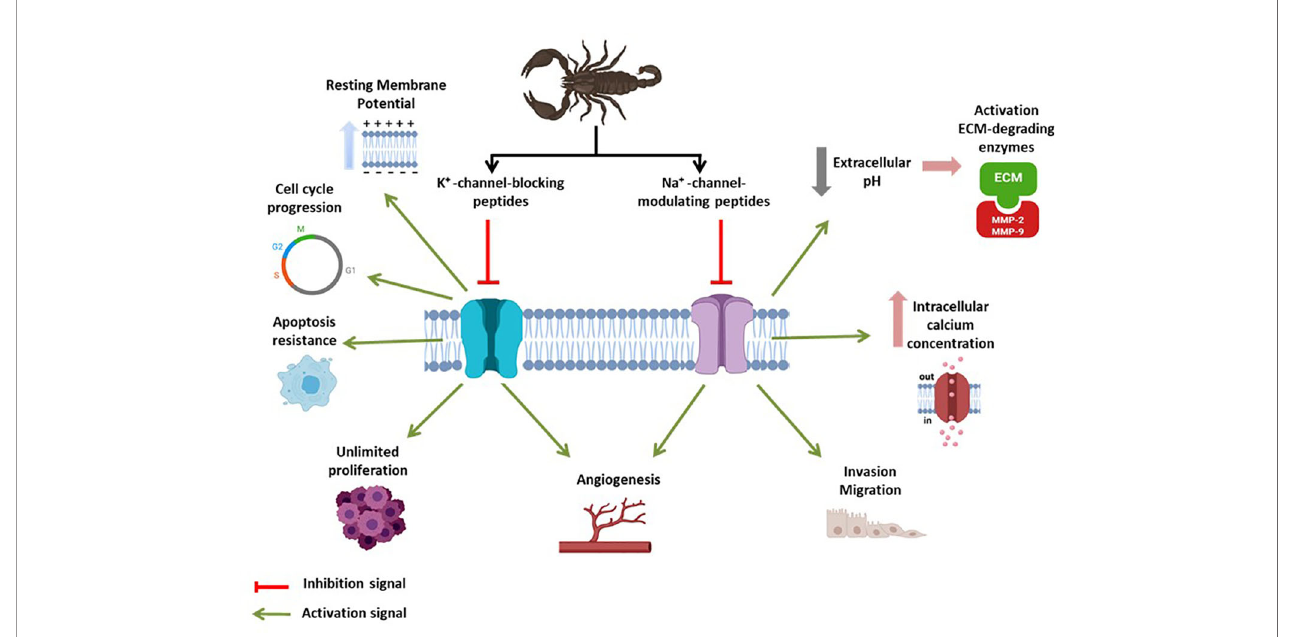
FIGURE 1 | The global effect of scorpion toxins on cancer-related voltage-gated K + /Na + -channels. An “ activation signal ” (green) indicates the pathological feature of ion channel activity in the context of cancer development. An “ inhibition signal ” (red) indicates inhibitory action of scorpion toxins, meaning cancer-hallmark